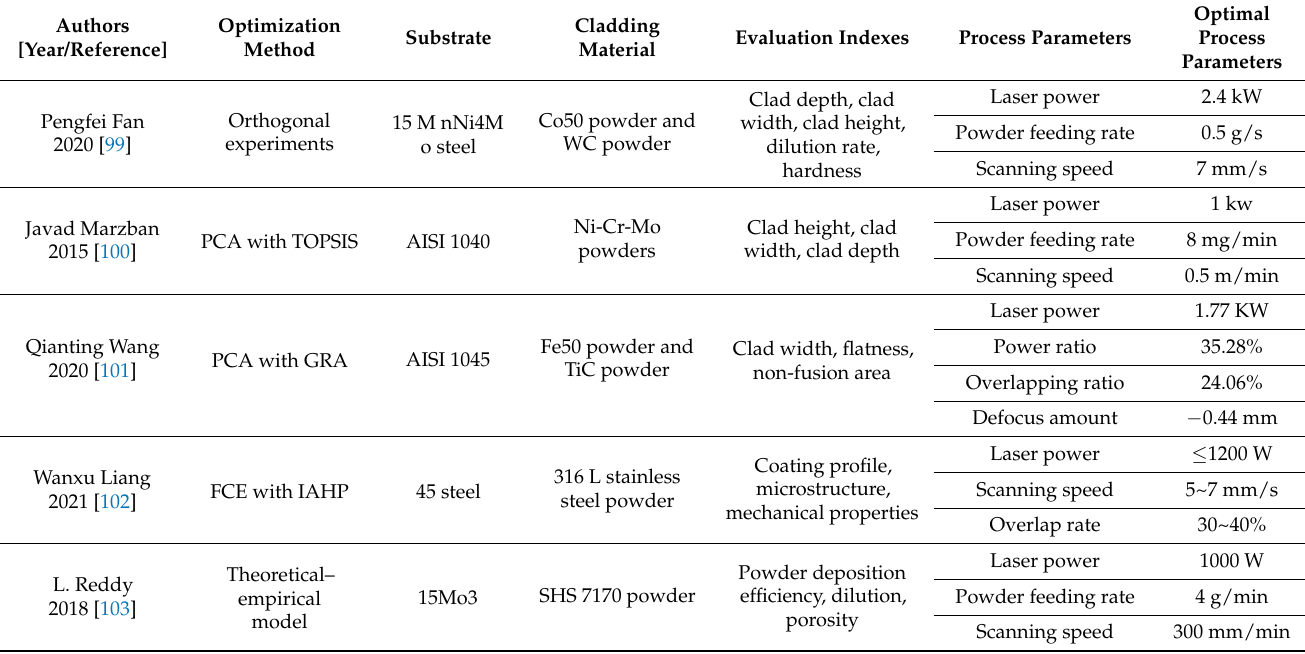
Table 3. The optimization methods and evaluation